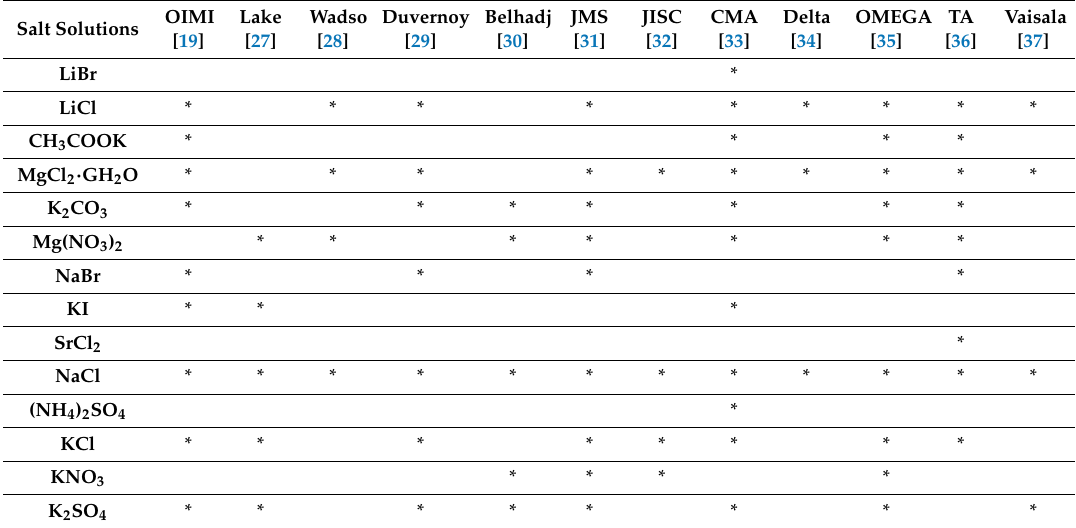
Table 1. The selection of saturated salt solutions that are used to calibrate humidity sensors. Salt